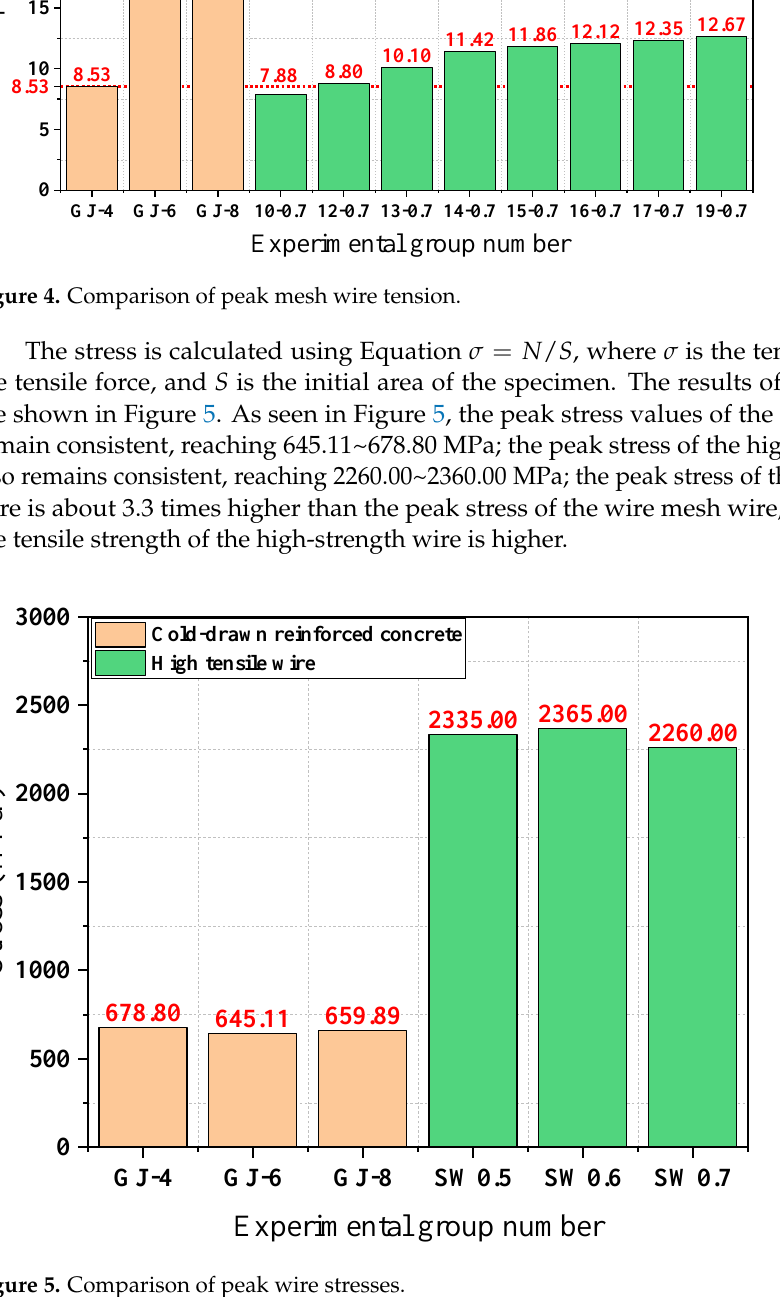
Figure 5. Comparison of peak wire stresses.